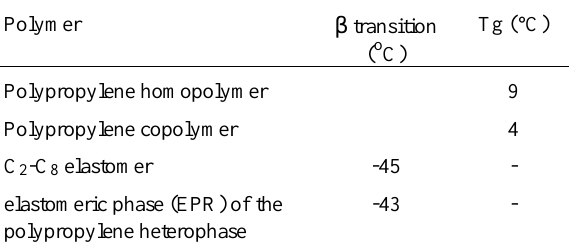
Table 2. Transition temperatures ( β and Tg) of all the materials used.